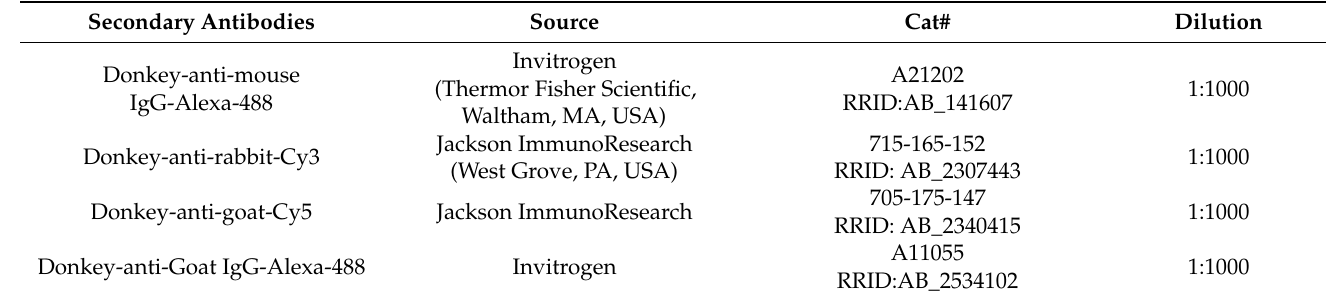
Table 3. List of secondary antibodies used for